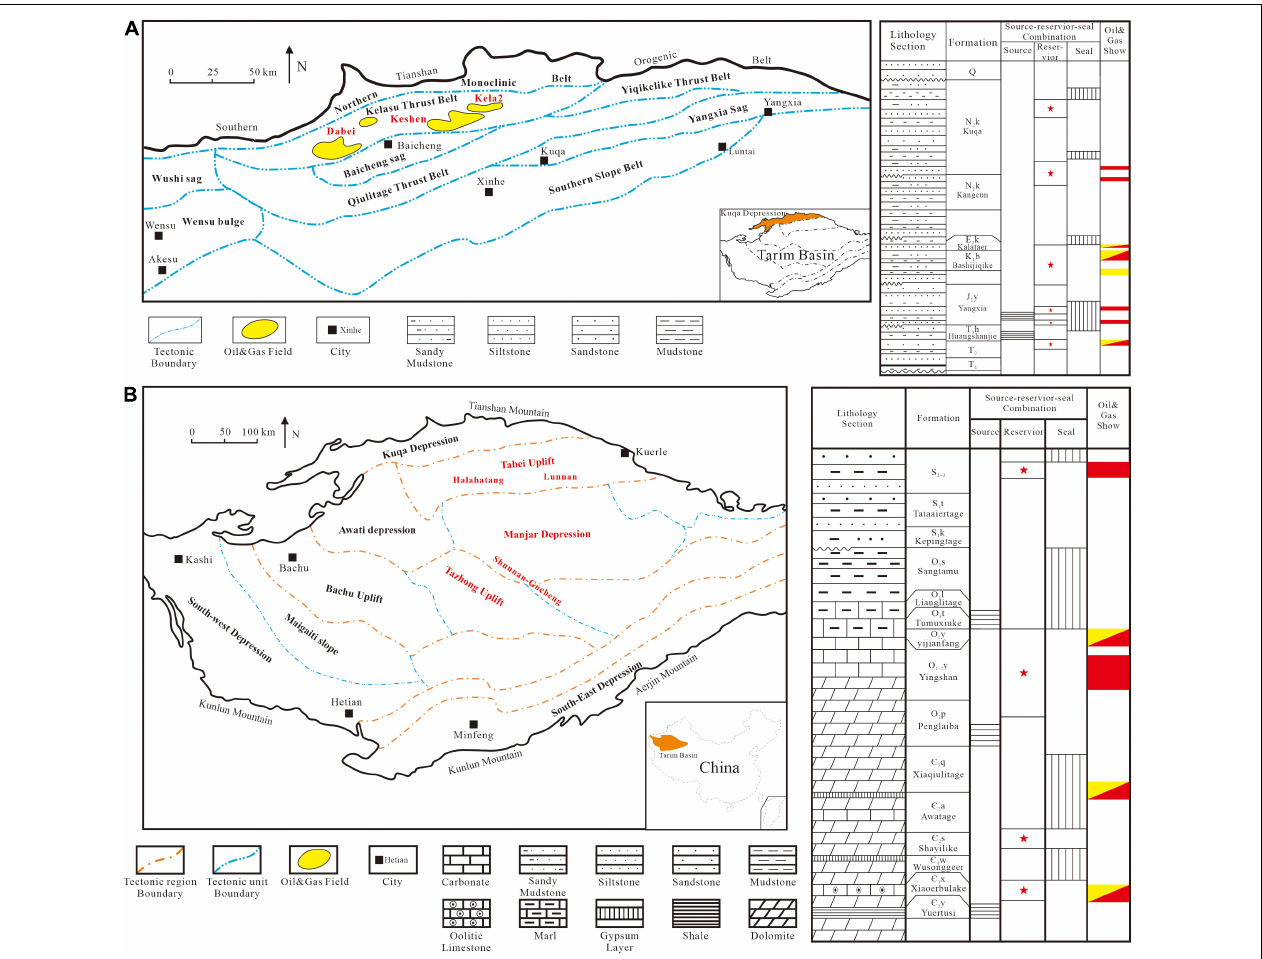
FIGURE 1 | (A) Location map of the Dabei, Keshen, and Kela2 gas fields in the Kuqa depression, Tarim Basin and the stratigraphic column of the Kuqa depression (Wang J. et al., 2018; Zhao et al., 2018). (B) Location map of the cratonic Tarim basin and the corresponding stratigraphic column (Ni et al., 2013; Zhu et al.,